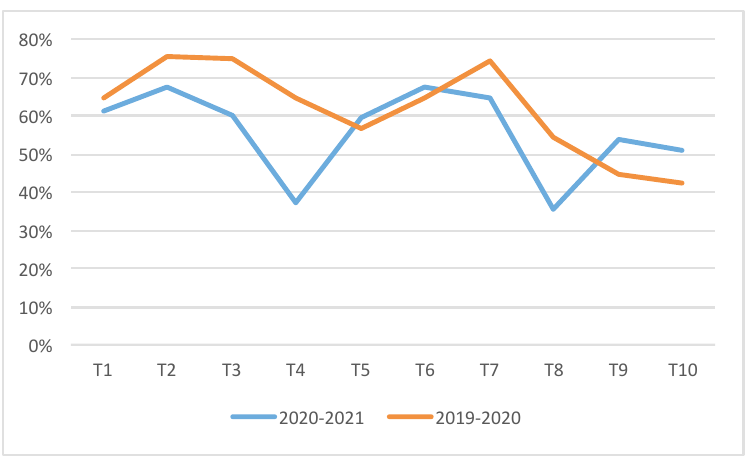
Figure 1. Evolution of the success rate in correct answers per topic in the 2019–2020 and 2020–2021 school